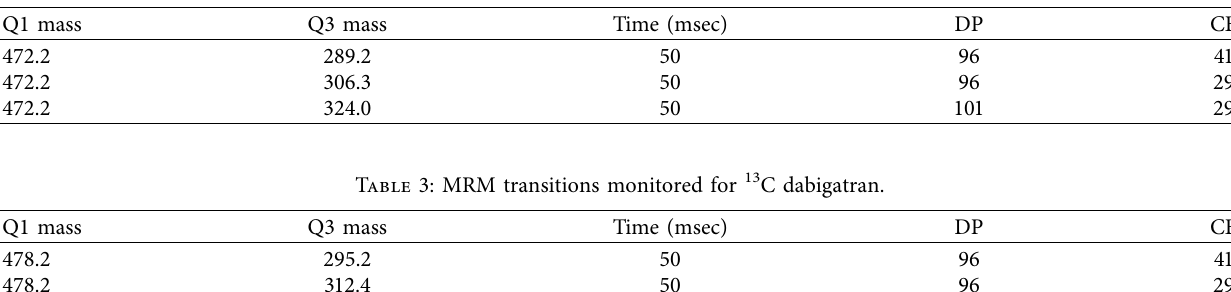
Table 2: MRM transitions monitored for dabigatran.